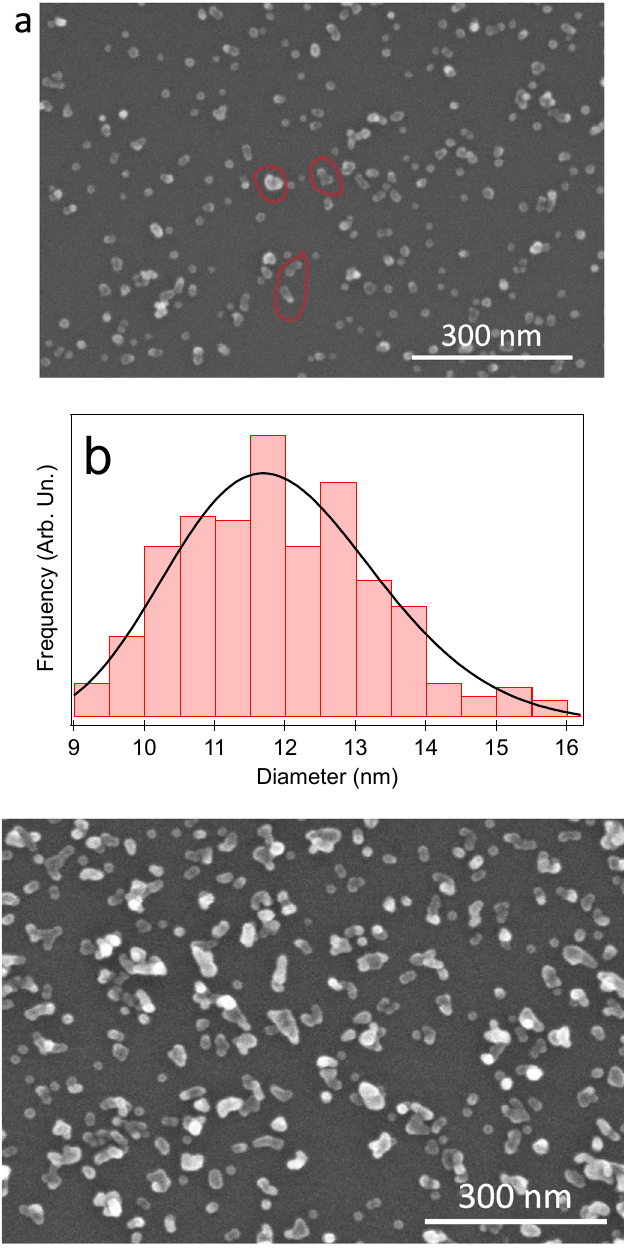
Figure 1. ( a ) SEM image of Cu NPs deposited on Si/SiO x with nominal thickness t = 0.5 nm, fractional coverage C = 4%; ( b ) lateral size distribution of the NP assembly shown in ( a ); ( c ) SEM image of Cu NPs deposited with t = 2.4 nm, C = 15%.